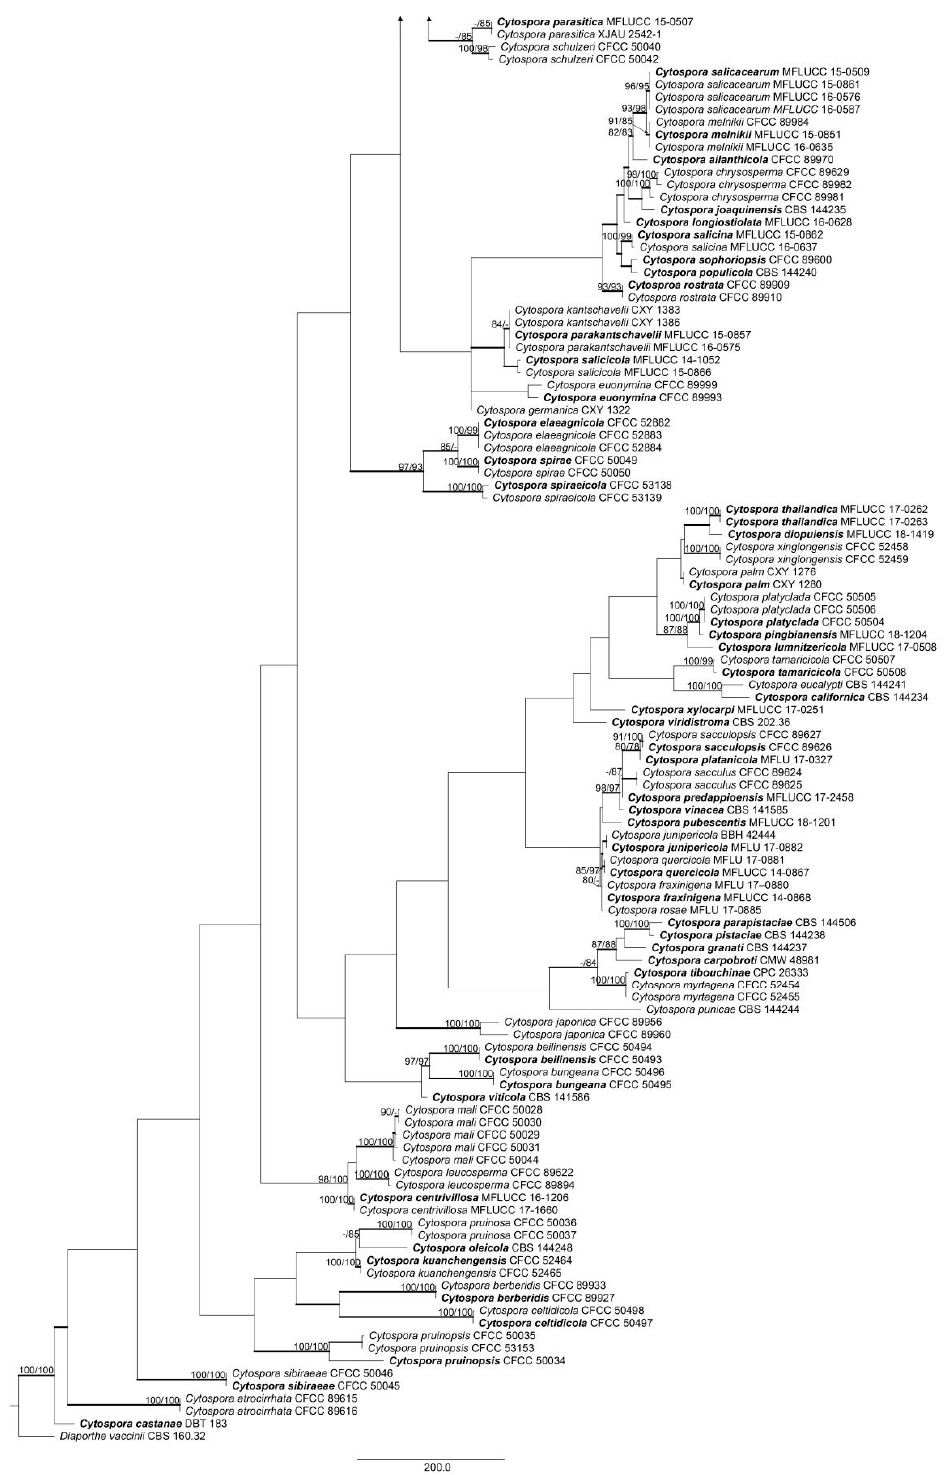
Figure 1. Phylogram of the best-parsimonious tree of Cytospora based on combined actin (ACT), internal transcribed spacer (ITS), RNA polymerase II second largest subunit (RPB2), translation elongation factor 1-alpha (TEF1- α ) and beta-tubulin (TUB2) genes. Maximum parsimony (MP) and maximum likelihood (ML) bootstrap support values above 70% are shown at the first and second positions, respectively. Thickened branches represent posterior probabilities from Bayesian inference (BI) above 0.95. Scale bar = 200 nucleotide substitutions. Diaporthe vaccinii CBS 160.32 was used as the outgroup. Ex-type strains are in bold. Strains from the current study are in bold and